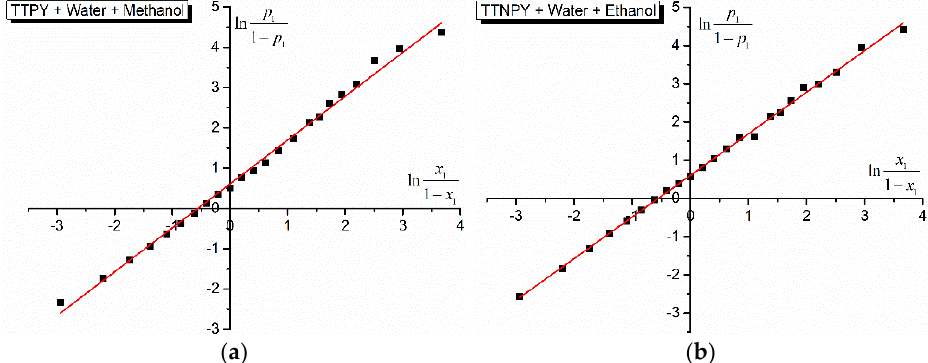
Figure 6. ln p 1 vs. ln x 1 for 4-tolyl-1,2,4-triazol-1-ium phenacylid (TTPY) ( a ) and 1 − p 1 1 − x 1